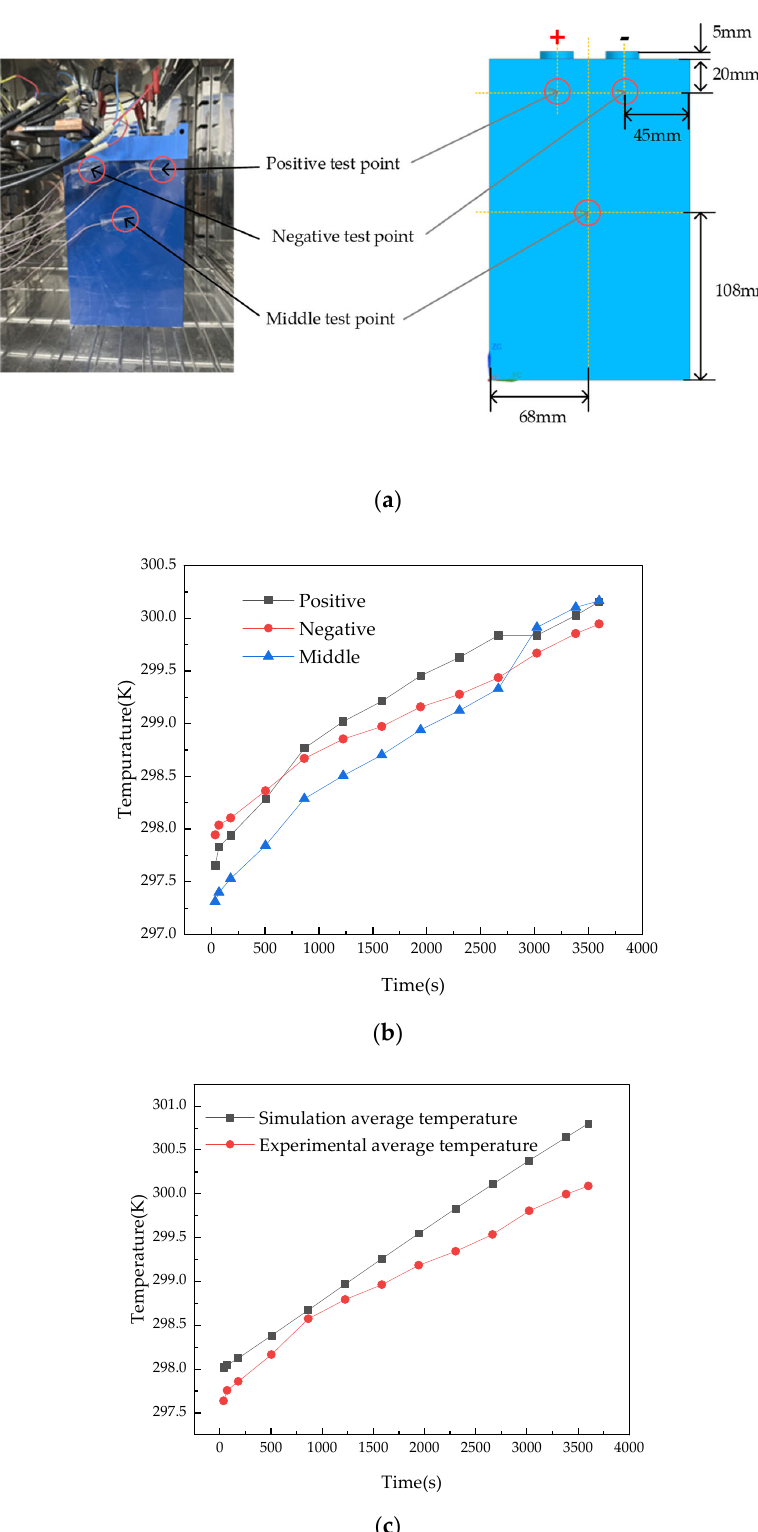
Figure 3. Cell experimental verification. ( a ) The location of the three points of battery temperature measurement. ( b ) The temperature at three points of 1C discharge. ( c ) Comparison of experimental and simulation results.